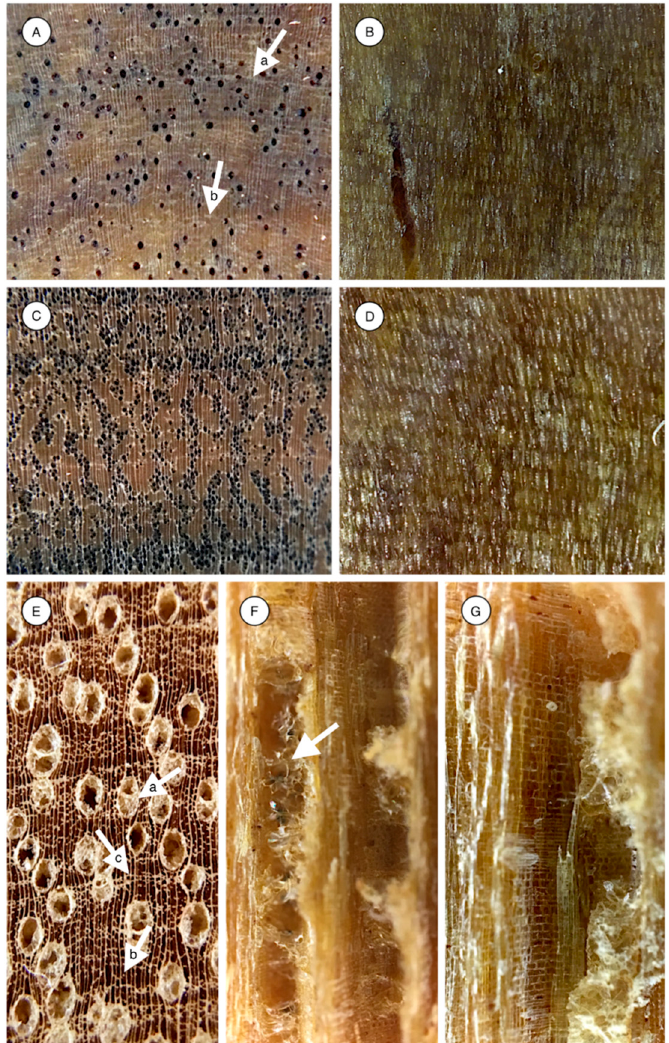
Figure 5. Elements visible with 400× lens in hardwoods. Guaiacum spp. ( A ) Solitary vessels; ( a ) marginal axial parenchyma; ( b ) diffuse-in-aggregate axial parenchyma; (B) storied rays, exclusively uniseriate. Bulnesia sarmientoi Lorentz ex Griseb., ( C ) bessels in radial or diagonal multiples of 4 or more. ( D ) Storied rays, 1 to 3 cells wide. Caryocar costaricense Donn.Sm., ( E ) diffuse-porous wood; ( a ) tyloses; ( b ) diffuse axial parenchyma; ( c ) diffuse-in-aggregate axial parenchyma. ( F ) Tyloses. ( G ) Rays with more than 4 rows of upright and/or square marginal cells.